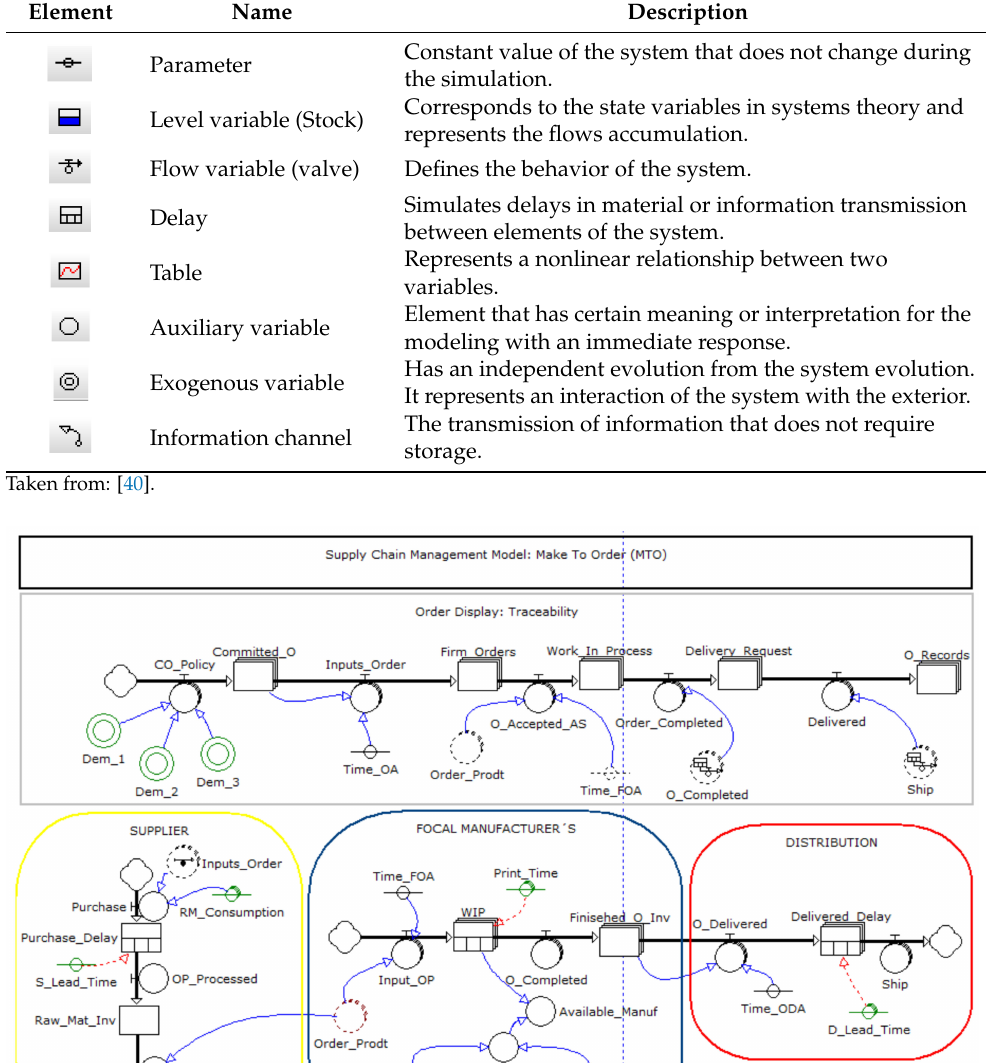
Table 3. Elements of the model.